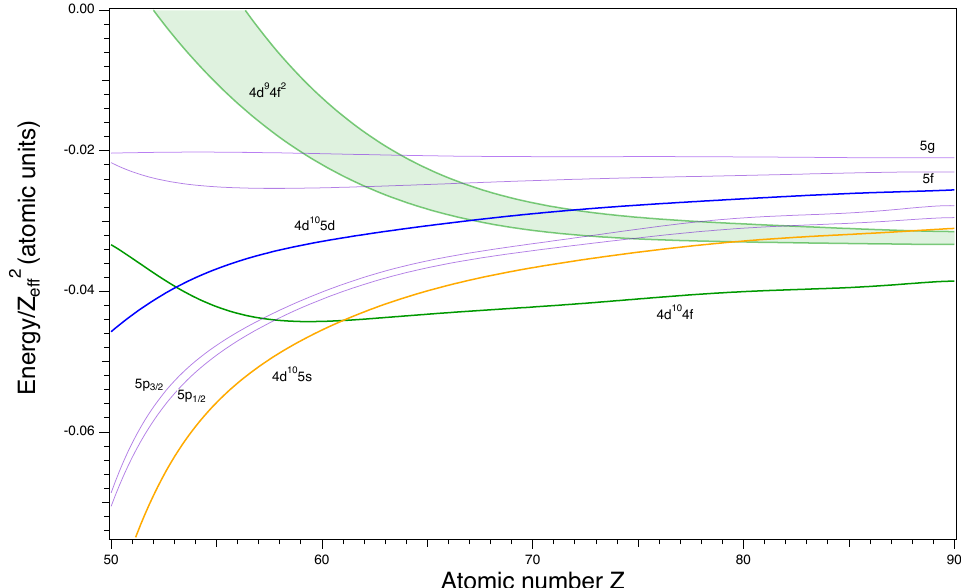
Figure 1. Scaled term values of the lowest excited levels in Ag-like ions [5] showing the level crossings of the 4d 10 4f and 4d 9 4f 2